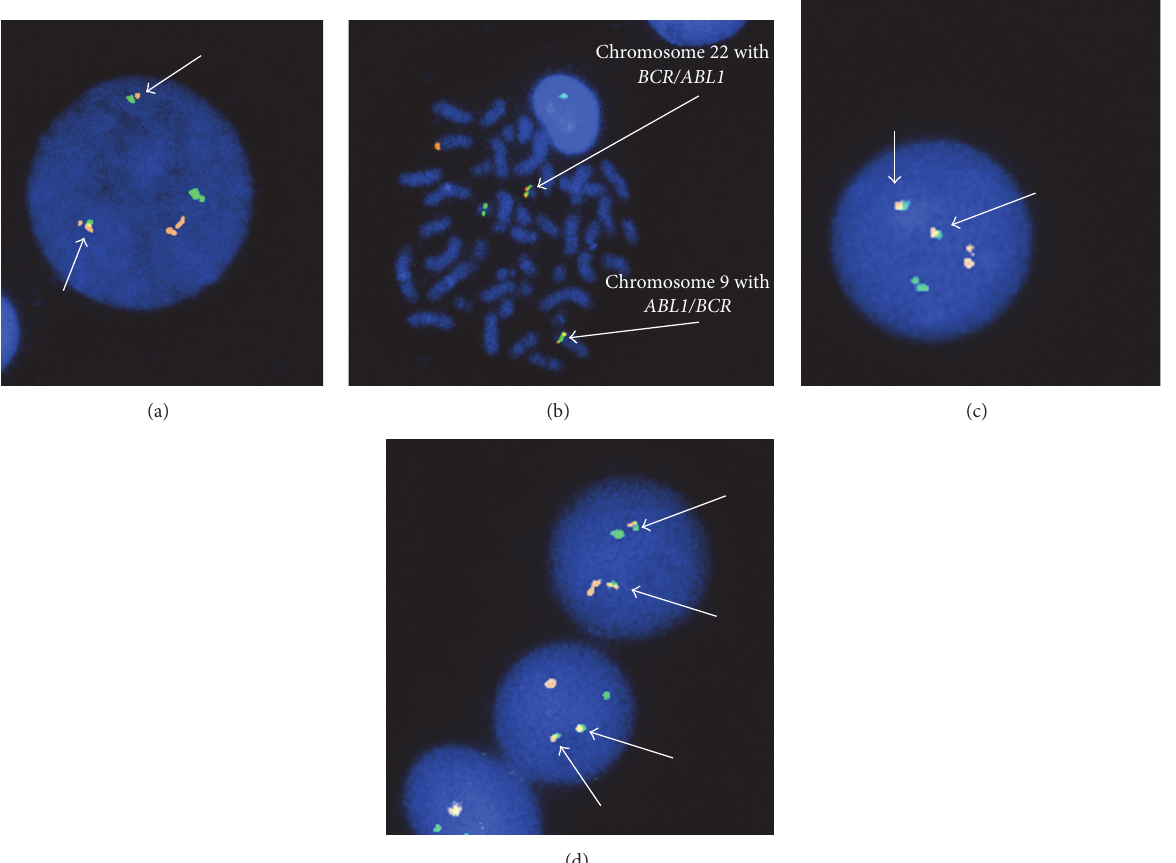
Figure 2: (a) BCR / ABL1 dual fusion positive interphase nucleus; (b) BCR / ABL 1 and ABL/BCR positive metaphase cell (arrows indicate fusion products); (c) and (d) IgH / CCND1 dual fusion positive interphase nuclei (arrows indicate fusion